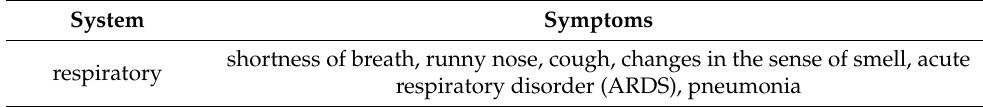
Table 1. Selected symptoms of SARS-CoV-2 infection